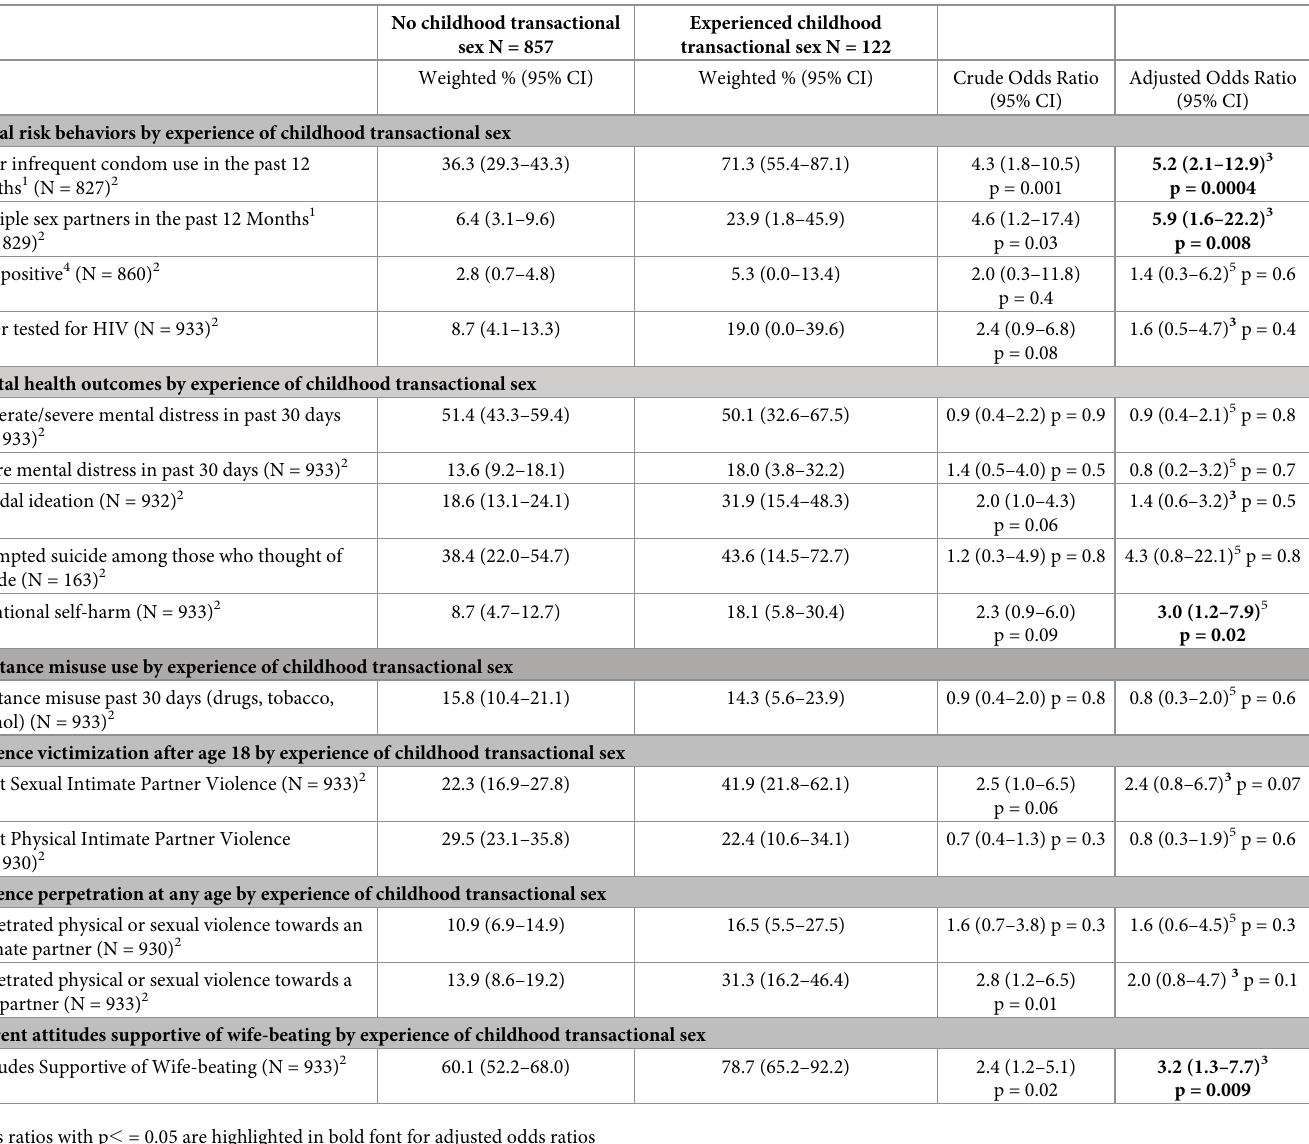
Table 3. Health behaviors and health outcomes among 18–24 year-old females in Uganda who ever had sex before age 18, by history of childhood transactional